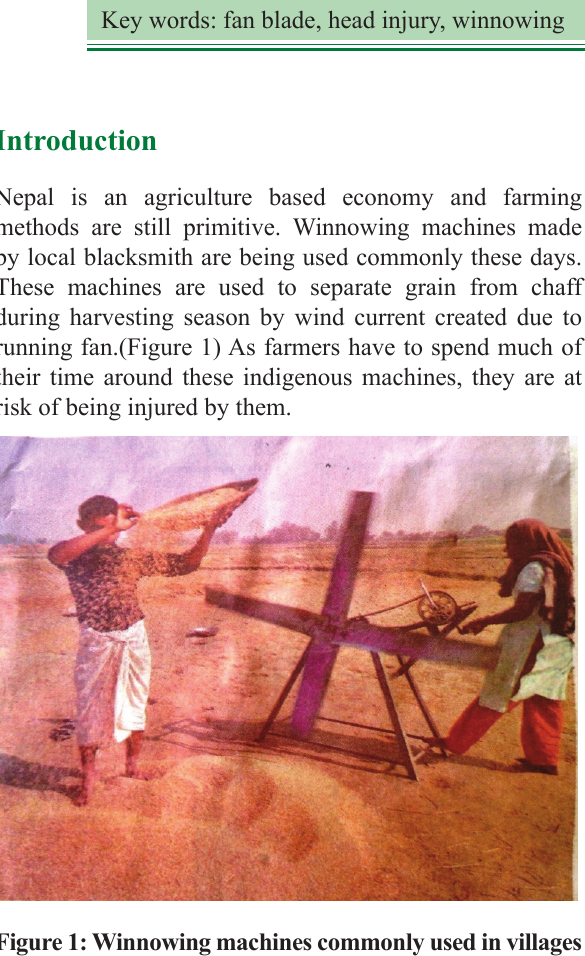
Figure 1: Winnowing machines commonly used in